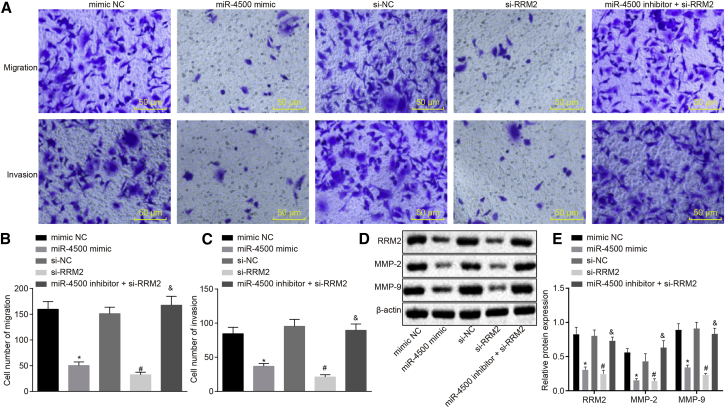
Overexpression of miR-4500 Suppresses the Expression of RRM2 to Inhibit Breast Cancer Cell Migration and Invasion(A) The migration and invasion of breast cancer cells in each group under the microscope (200×). (B) The cell migration in each group detected by Transwell assay. (C) The cell invasion in each group detected by Transwell assay. (D) The protein expressions of RRM2, MMP-2 and MMP-9 detected by Western blot. (E) Comparison of relative protein expressions of RRM2, MMP-2 and MMP-9 in each group. The data comparisons were analyzed by one-way ANOVA, and the experiment was repeated three times independently.